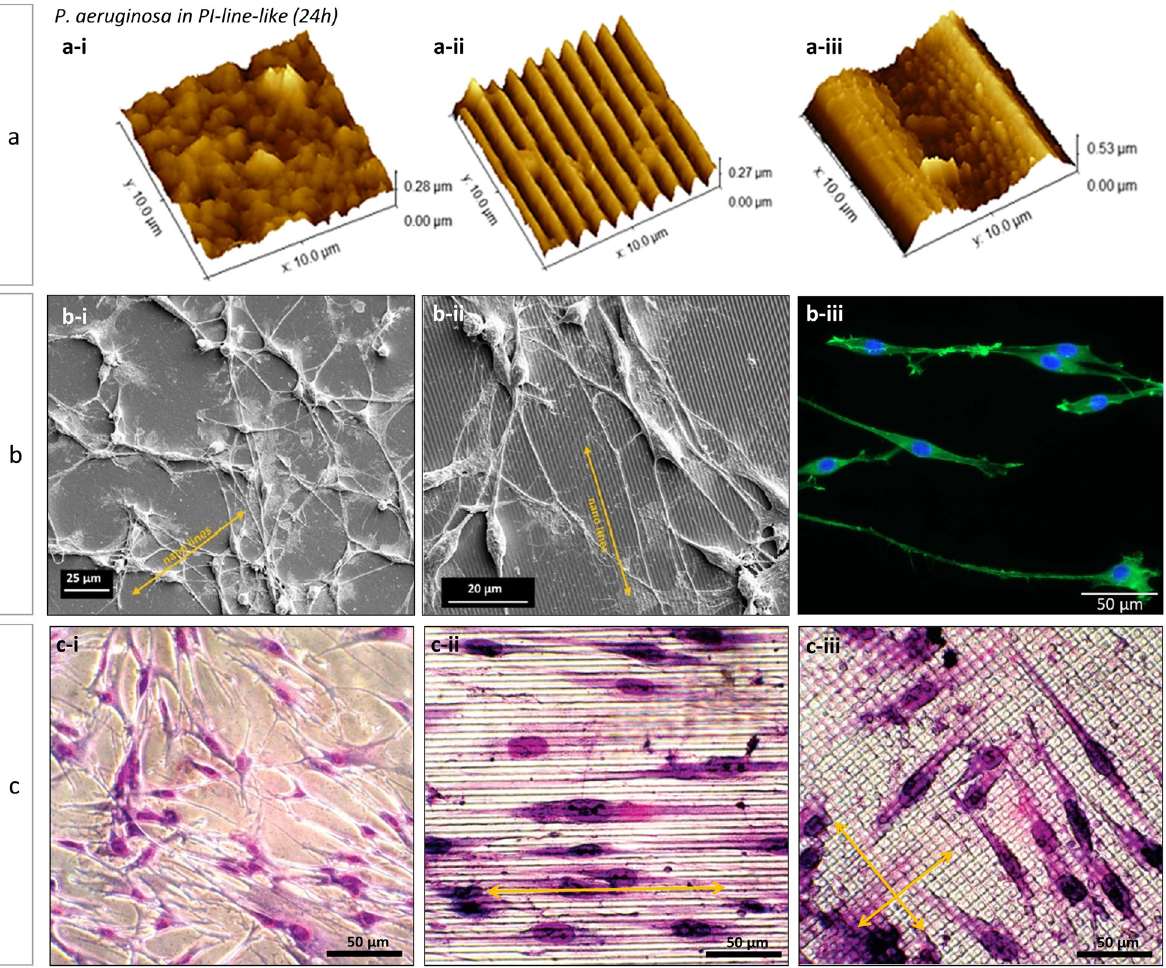
Figure 3: (a) AFM images of P . aeruginosa (24 h cultivated) in (a-i) PI unstructured, (a-ii) PI-line-like 1 µm and (a-iii) PI-line-like 10 µm fi lms; (b)SEMimagesofB35cellsonDLIP-generatednanopatternsonPEEKwith1000nmperiodicitywith(b-i)50nmdeepgroovesand(b-ii)350nm deep grooves. (b-iii) Fluorescence microscopy showing the alignment of B35 cells on PEEK-nanopatterns. Fluorescent staining: DAPI